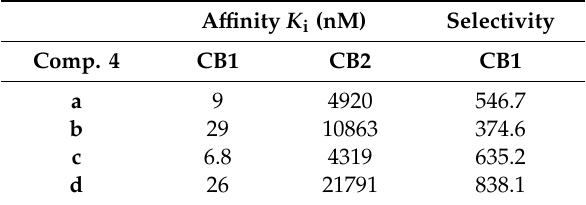
Table 1. A ffi nity constant and selectivity of CB1 / CB2 antagonists 4a – d